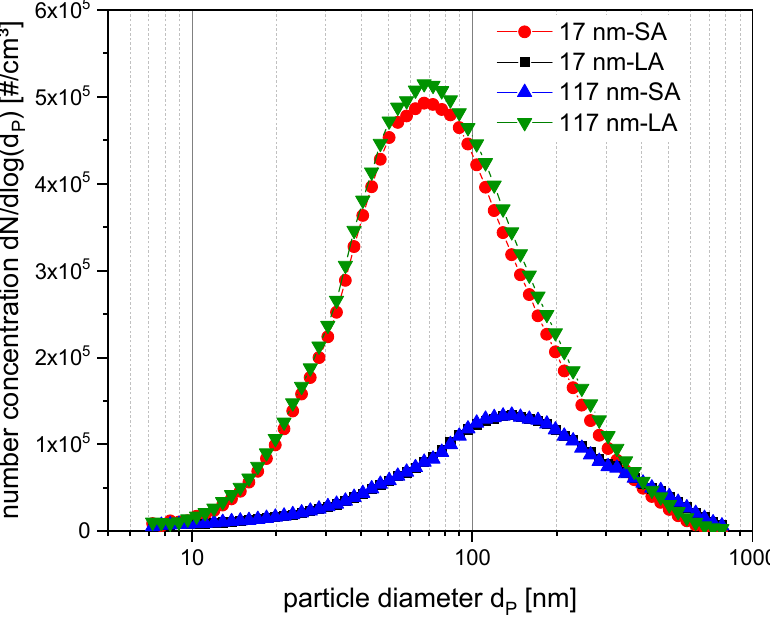
Figure 2. Particle size distributions of TiO 2 agglomerates measured by Scanning Mobility Particle Sizer U-SMPS in the range of 8 to 800 nm. Each curve shows the means of number size distributions in dependence of particle type and agglomeration state. Red circles: 17 nm-SA; black squares: 17 nm-LA; blue triangles: 117 nm-SA; and green inverted triangles: 117 nm-LA. Table 2. Characteristics of TiO 2 aerosols and measured or calculated deposited surface doses on cell